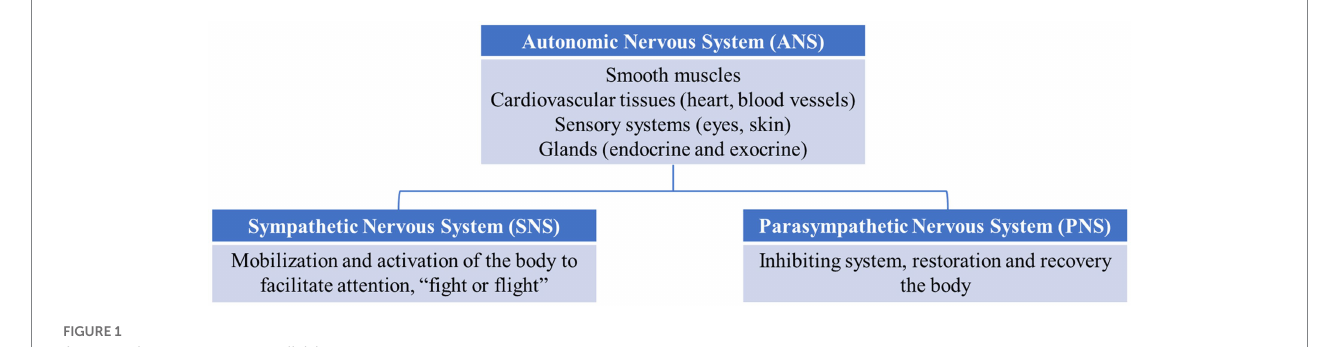
FIGURE 1 Autonomic nervous system